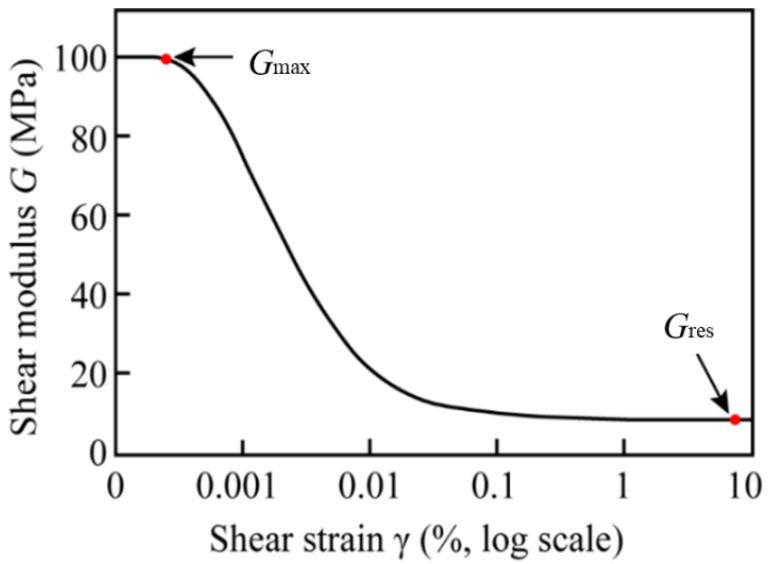
Figure 9. Schematic diagram of pressuremeter stiffness and shear strain (modified according to Whittle and Liu, 2013 [19]).